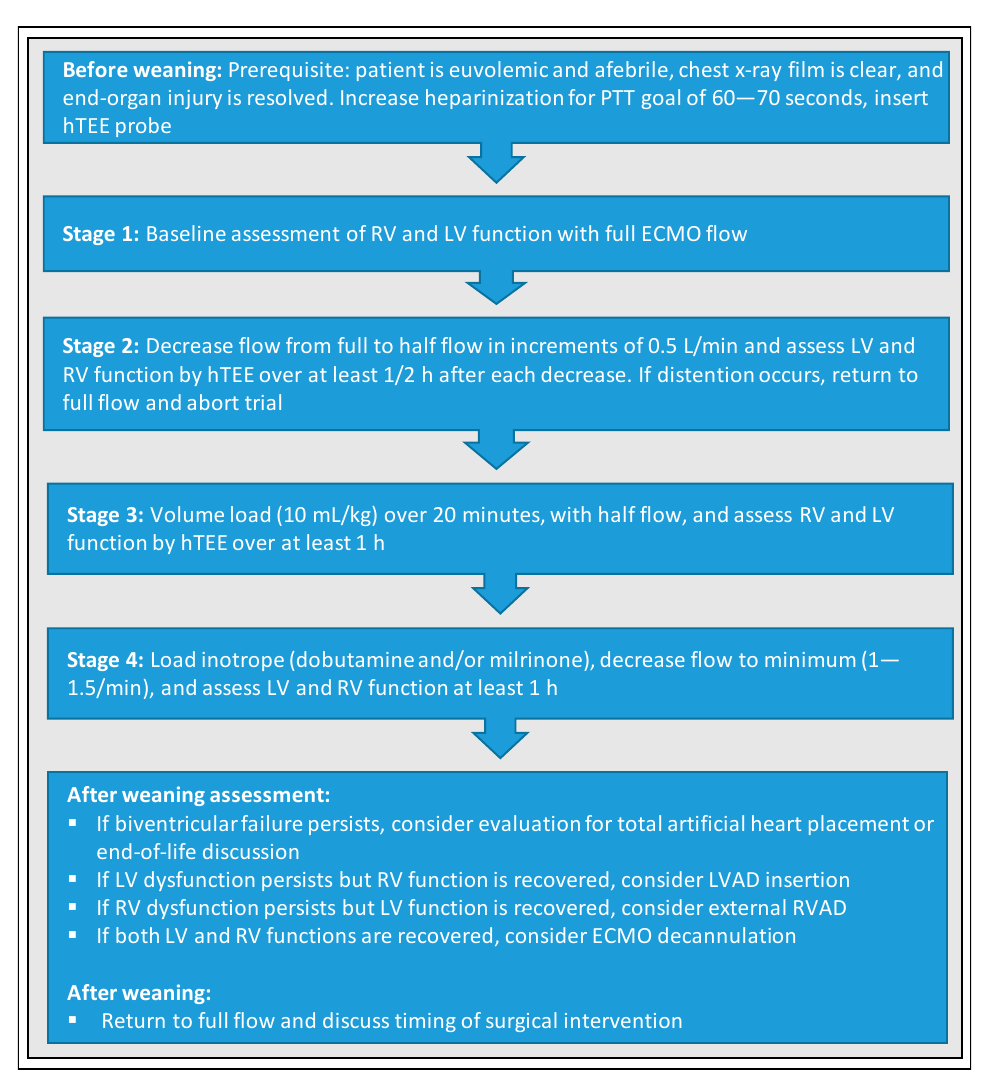
Figure 4. Standardized protocol for weaning from VA-ECMO according to Cavarocchi et al. [5]. PTT, partial thromboplastin time; hTEE, hemodynamic transoesophageal echocardiography; LV, left ventricle; RV, right ventricle; LVAD, left ventricular assist device; RVAD, right ventricular assist device.